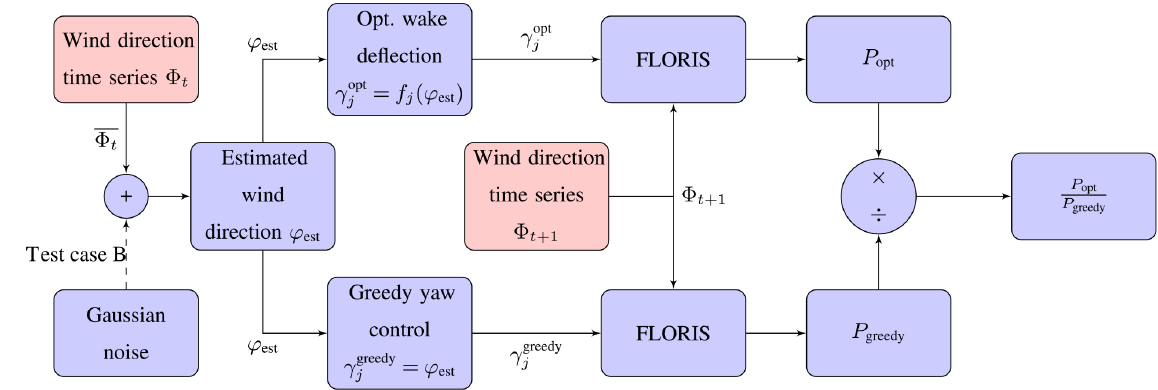
Figure 10. Evaluation process of the control schemes with wind direction measurements. Red boxes mark the steps in which the measured data are used as input.